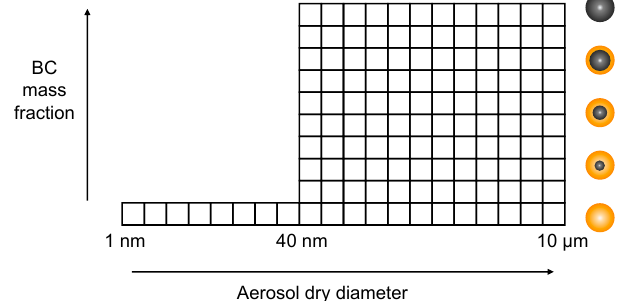
Figure 1. Aerosol bin representation used in the ATRAS module. Particles with dry diameters from 40nm to 10µm are placed into two-dimensional bins. One dimension is aerosol dry diameter (12 bins from 40nm to 10µm) and the other is the fraction of BC mass relative to total aerosol mass concentration under dry condition (10 bins: pure-BC particles, BC-free particles, and 8 different internally mixed BC particles). The particles with dry diameters from 1 to 40nm are divided into eight size bins to calculate